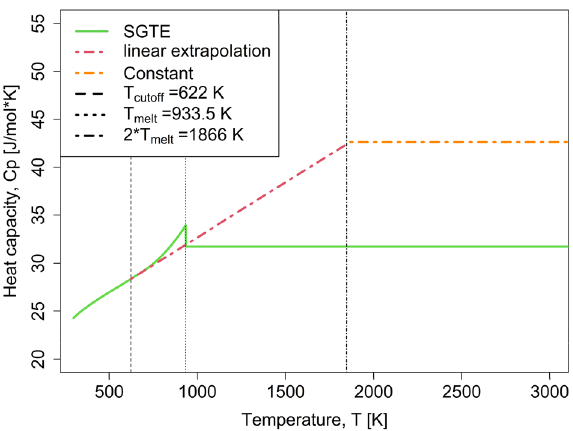
Figure 2. Modified heat capacity description for FCC-Al used for applying the proposed model (dotted-point line) compared with SGTE 44 description (solid